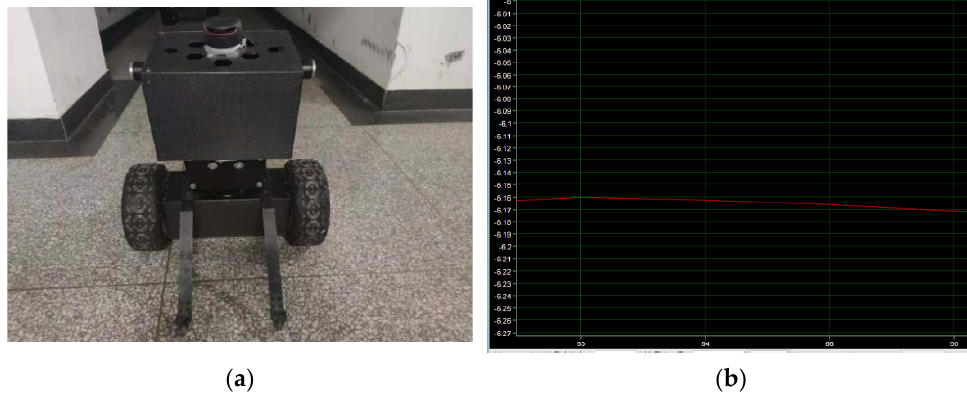
Figure 20. ( a ) Robot static experiment. ( b ) Waveform of robot at rest.